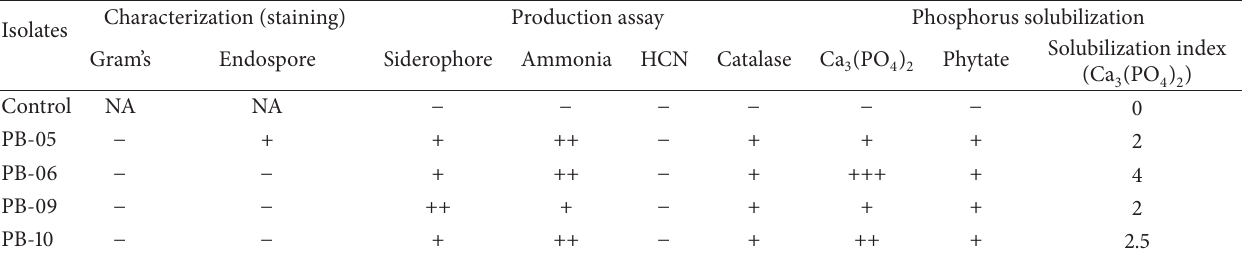
Table 1: Plant growth promoting characters of phytase producing bacterial